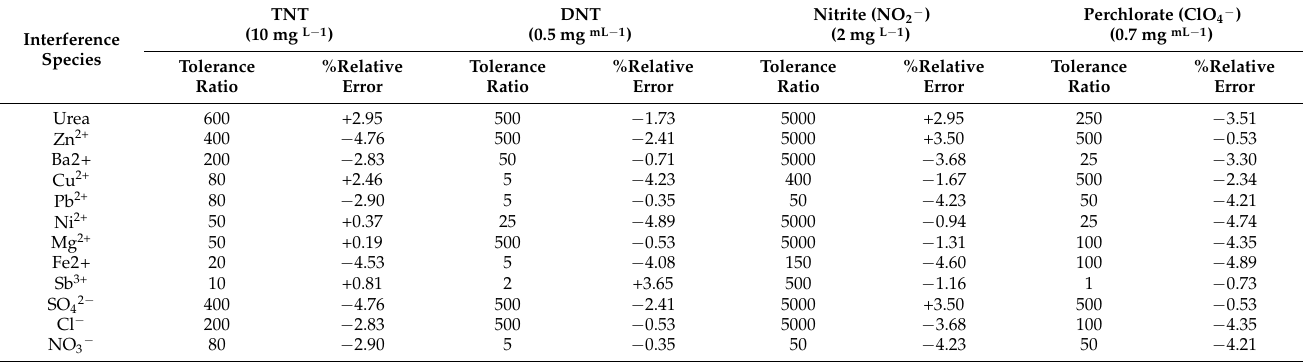
Table 5. Tolerance limits of potential interferences on the determination of 10 mg L − 1 TNT, 0.5 mg mL − 1 DNT, 2 mg L − 1 nitrite, and 0.7 mg mL − 1 perchlorate.